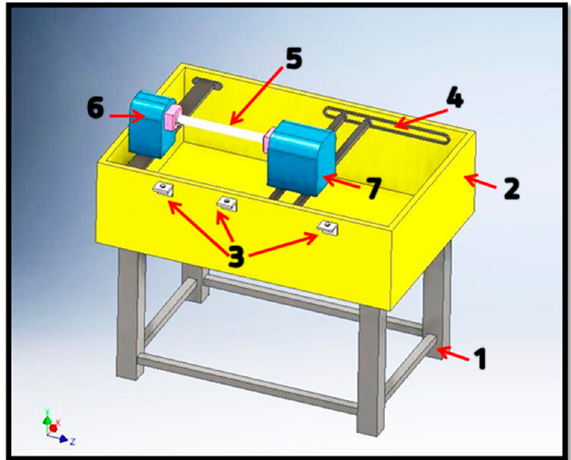
Figure 5. Equipment components: 1—support soles; 2—basin; 3—electrically operated buttons; 4—